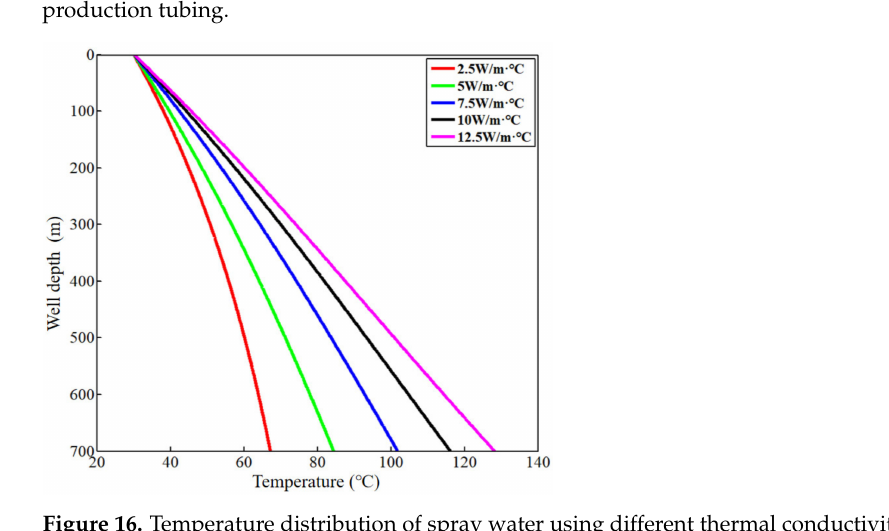
Figure 16. Temperature distribution of spray water using different thermal conductivities of produc- tion